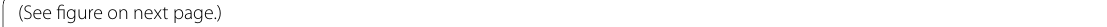
figure on next Fig. 1 Diversity and composition of cultured gut bacterial communities in various media and uncultured feces. Shannon ( a ), faith pd ( b ), observed OTUs ( c ), and evenness index ( d ) in various media and uncultured feces. Boxes show medians and interquartile ranges (IQRs); whiskers denote lowest and highest values within 1.5 times the IQR from the first and third quartiles; outliers are shown as individual points. e Principal co-ordinates analysis (PCoA) of fecal cultured communities in various media and uncultured